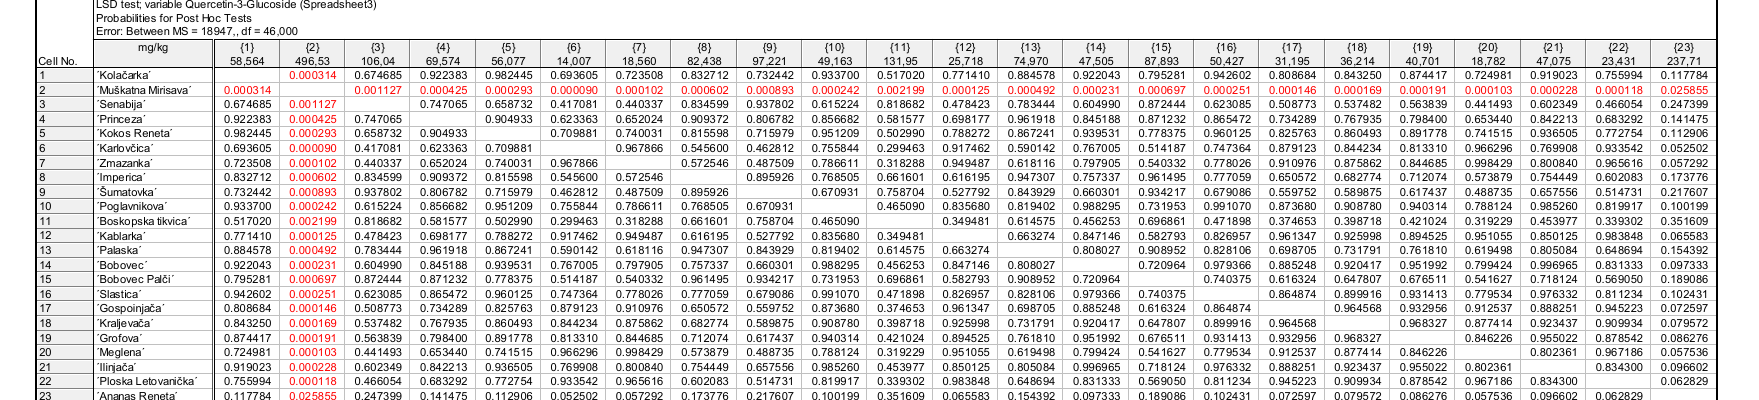
Figure A6. The statistical significance of quercetin-3-glucoside in traditional apple varieties; the p -values of the correlations of identified polyphenols. Statistically significant p -values are marked red ( p < 0.05).